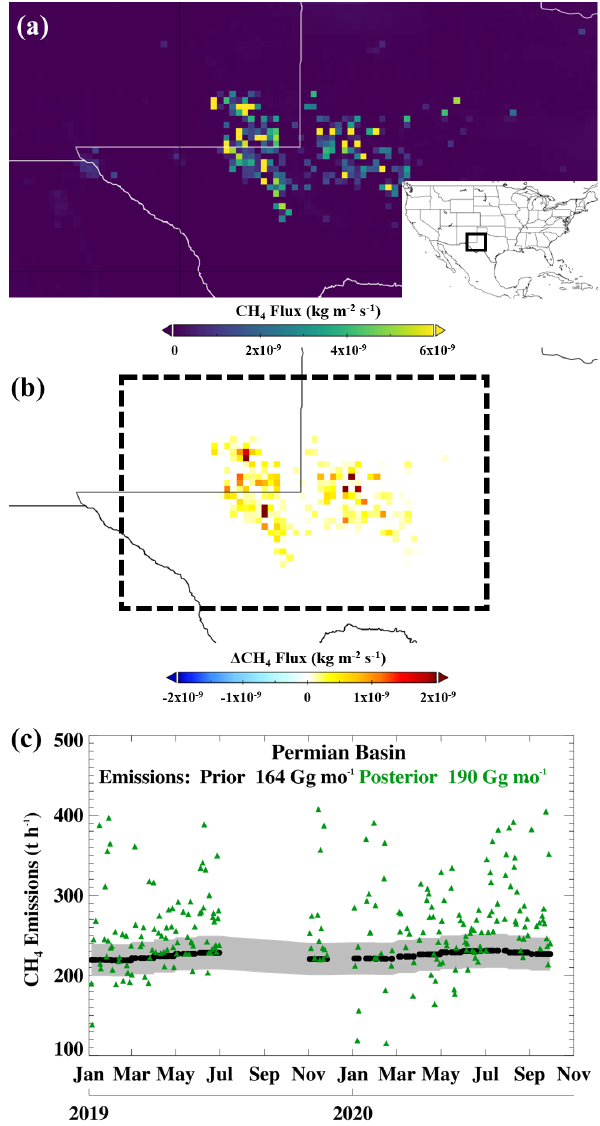
Figure 3. (a) Average prior Permian Basin CH 4 emissions for 2019. (b) Average of posterior minus prior anthropogenic CH 4 emissions over the Permian Basin for January–June 2019, excluding days for which observations were not available. (c) Time series of total prior (black circles) and posterior (green triangles) anthropogenic CH 4 emission estimates within the 6 ◦ × 4 ◦ Permian Basin domain, cen- tred around 32 ◦ N, 103 ◦ W (black box in b ) for 2019–2020, ex- cluding days for which observations were not available. The shaded error denotes prior